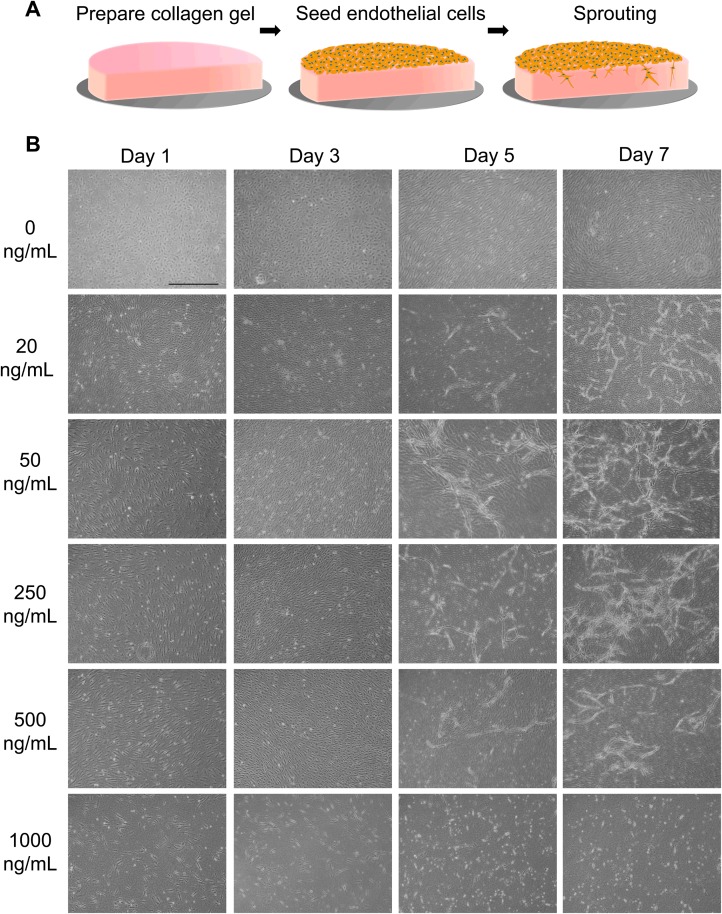
Effects of PMA on endothelial cell vascularization in collagen gel.(A) Schematic diagrams of the experimental design. (B) Phase-contrast microscopy images of HUVECs exposed to various PMA concentrations. HUVECs did not sprout into the collagen gel in the absence of PMA, forming a monolayer on the surface. When exposed to 20–500 ng/mL PMA, HUVECs formed typical luminal structures. At 1000 ng/mL PMA, sprouting was inhibited and cells became detached. Scale bar, 1 mm.